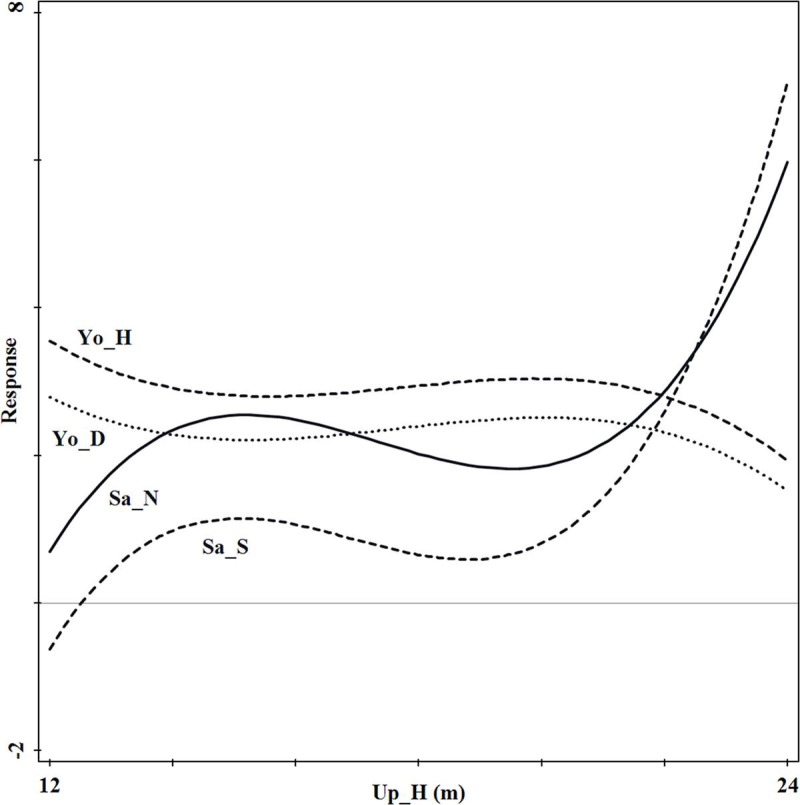
Regeneration response curves to the most important upper forest
stratum structure index (Up_H).Sa_N and Sa_S denote sapling density and tree species richness index,
respectively; Yo_D and Yo_H denote young tree diameter at breast
height and tree height, respectively.